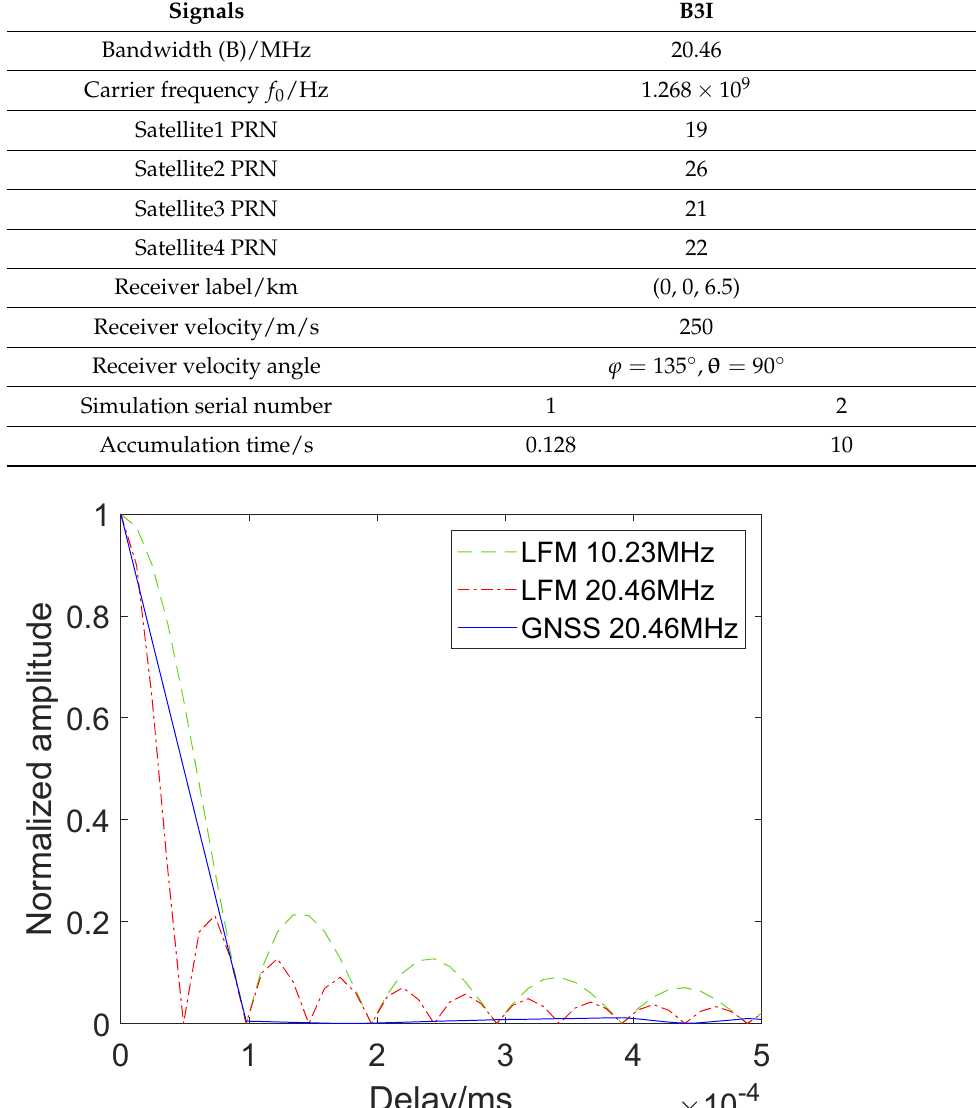
Figure 3. Autocorrelation curves of GNSS B3I and chirp signals.